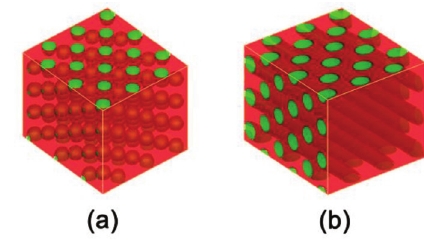
Figure 8: Equilibrium morphologies for bulk of dendrimer copolymer: (a) spherical structure for 0.60 ≤ χ ≤ 0.65, (b) cylindrical AB structure for 0.70 ≤ χ ≤ 0.80. AB